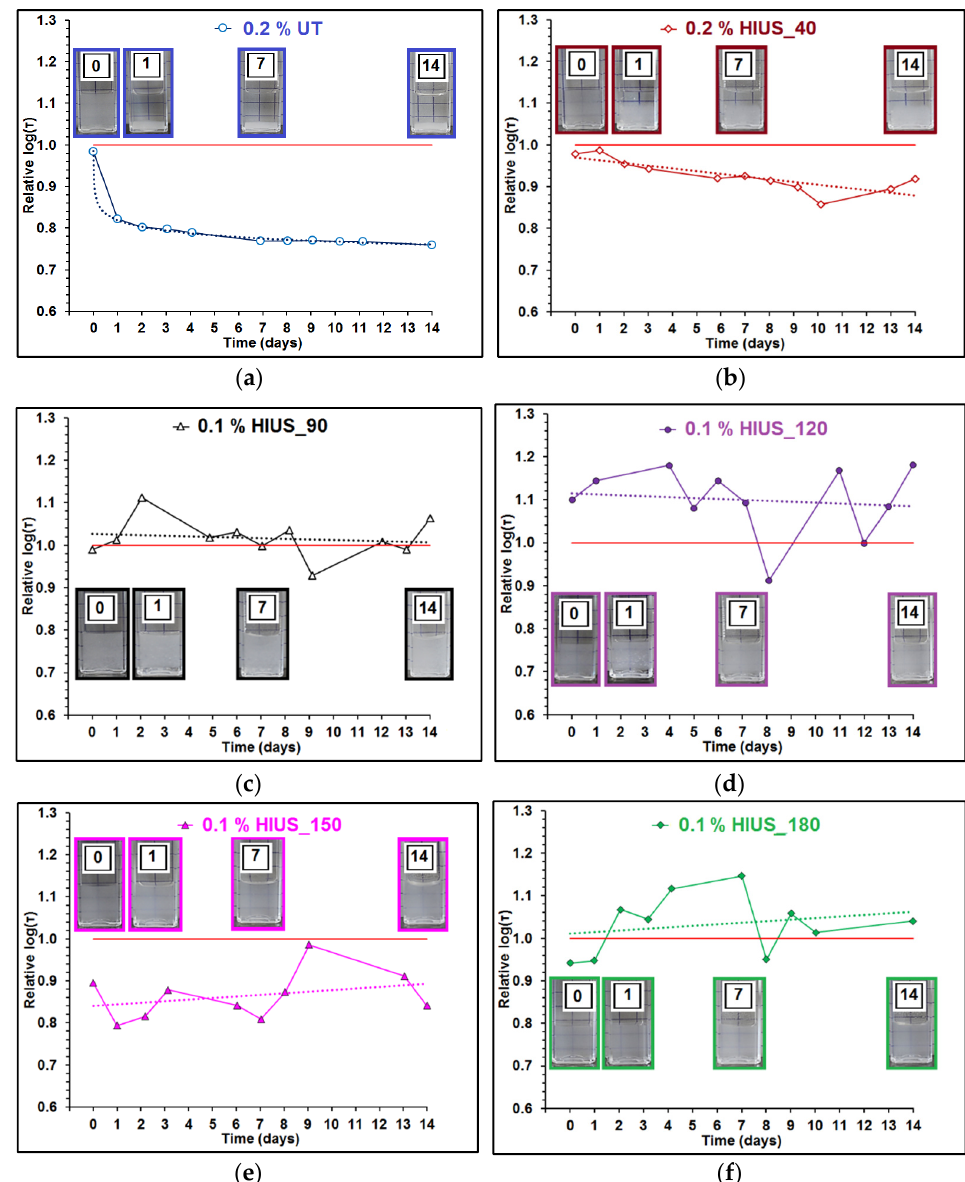
Figure 7. Relative log( τ ) obtained during 14 days of experiment for ( a ) cellulose microfibrils (0.2% UT), ( b ) 0.2% dispersion of cellulose prepared using high-intensity ultrasonication for 40 min. (0.2% HIUS_40), and 0.1% dispersion of cellulose prepared using high-intensity ultrasonication for ( c ) 90 min. (0.1% HIUS_90), ( d ) 120 min. (0.1% HIUS_120), ( e ) 150 min. (0.1% HIUS_150), and ( f ) 180 min. (0.1% HIUS_180), respectively; red solid line marks relative log( τ ) equal to 1; dotted lines show the fitted trend lines. The photographs of cuvette with cellulose dispersion are related to the consecutive days of measurements (0—initial day, 1—first day, 7—seventh day, 14—fourteenth day).